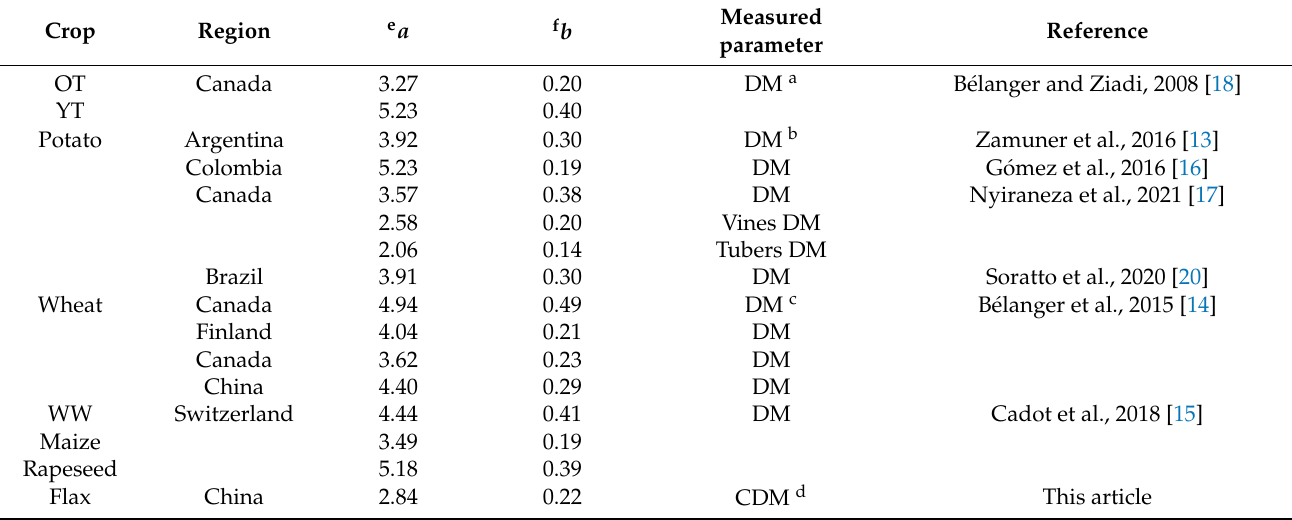
Table 3. Comparison of the parameters of the critical phosphorus concentration (Pc) dilution curve for different regions and measured parameters of timothy, potato, wheat, maize, rapeseed, and